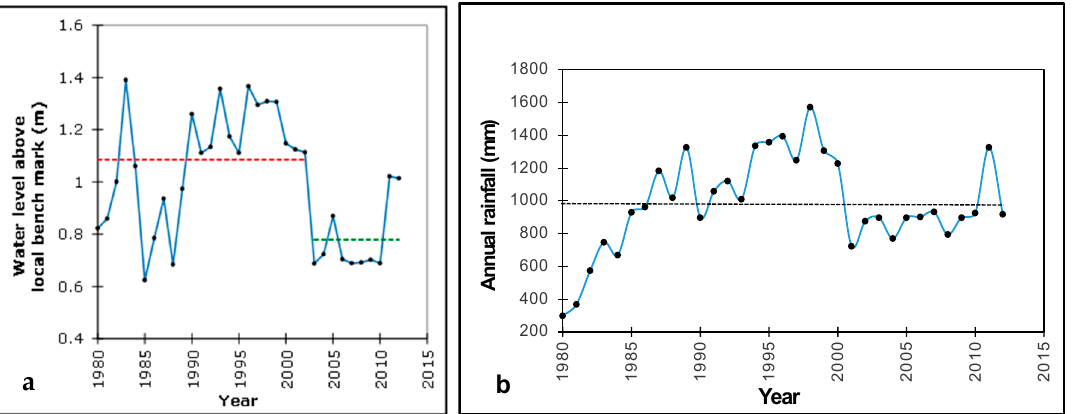
Figure 5. ( a ) Long term water level trend and regime shift. The red line represents mean water level before the regime shift and the green line shows mean water level after the regime shift; ( b ) long term mean annual rainfall in lake Ziway catchment area. The black line shows no monotonic trend in mean annual rainfall.